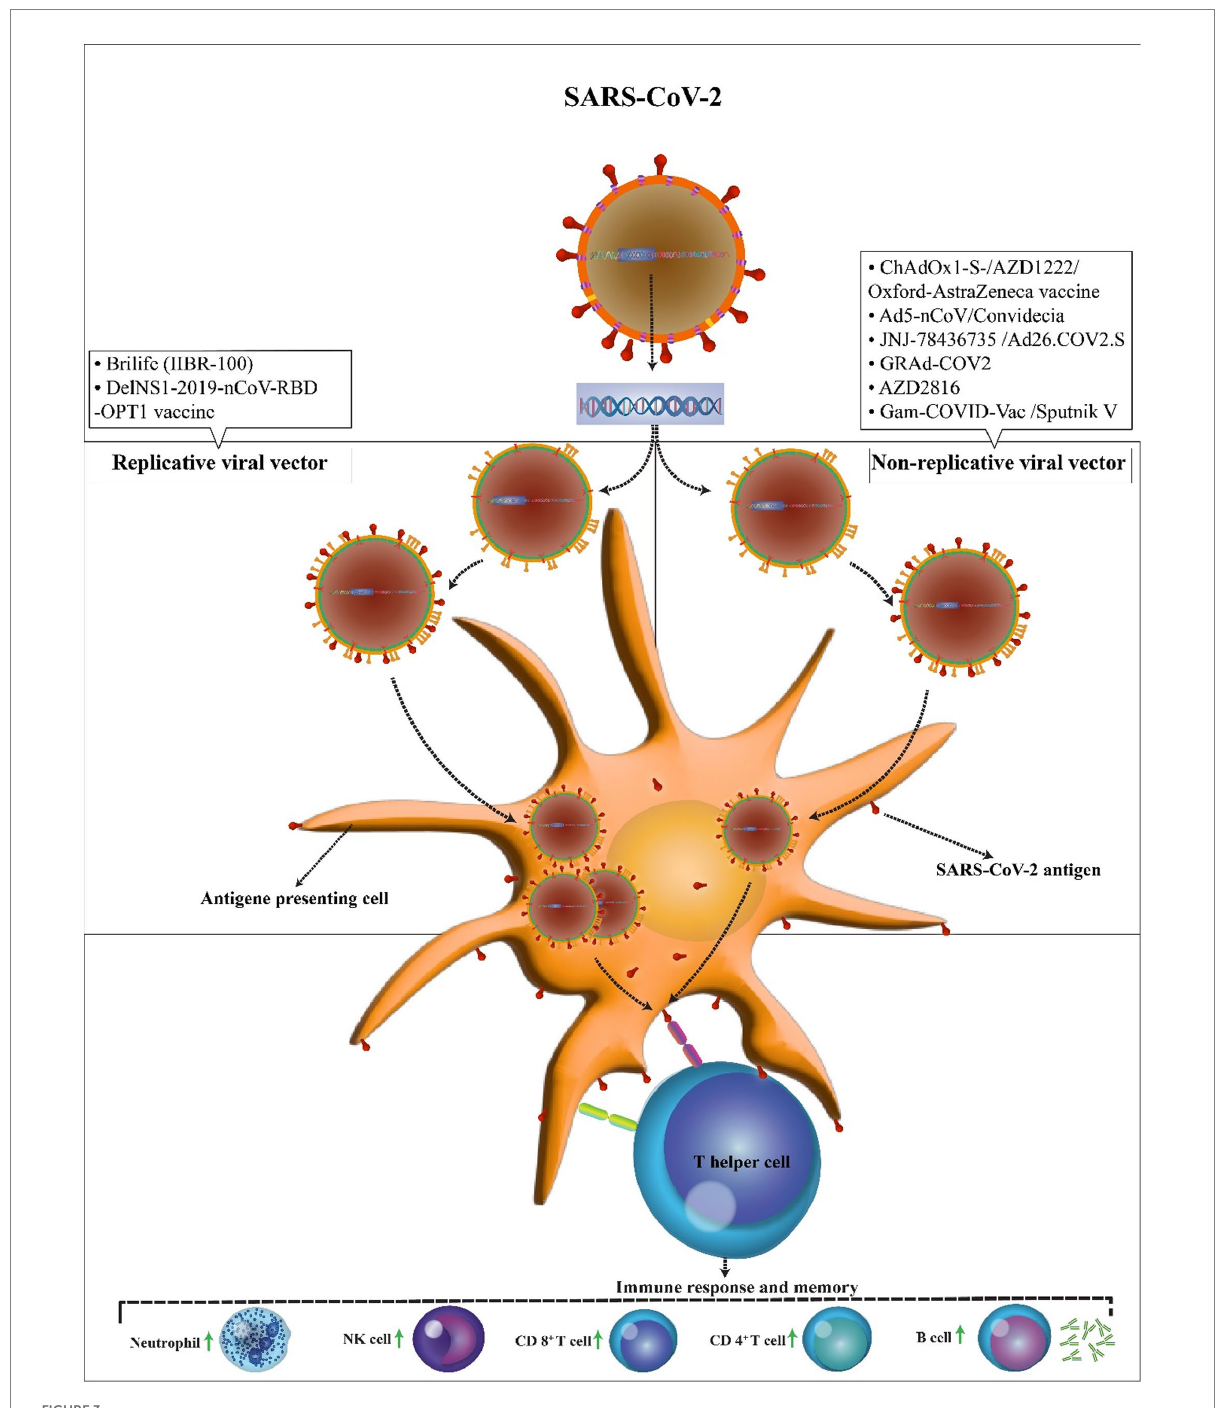
FIGURE 3 Mechanism of action of the COVID-19 vector vaccines. In comparison to replicating viral vectors, nonreplicating vectors have genetic deletions and unable to replicate inside the body. In both vaccines, the SARS-CoV-2 antigen can be presented to antigen-presenting cells. Then, T helper cells stimulate the immune responses including an increase in neutrophils, NK cells, CD 4+ T cells, CD 8+ T cells, and B